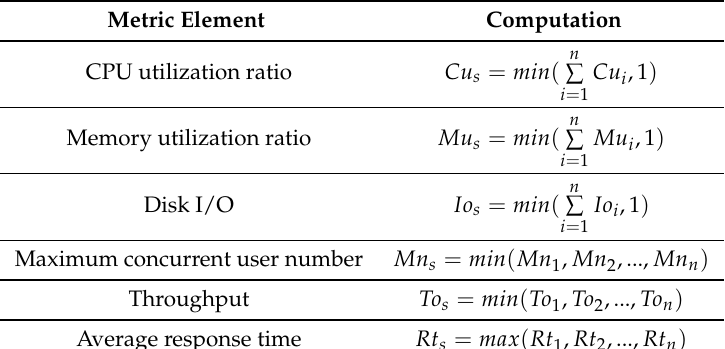
Table 6. The computation of the concurrence relationship system.